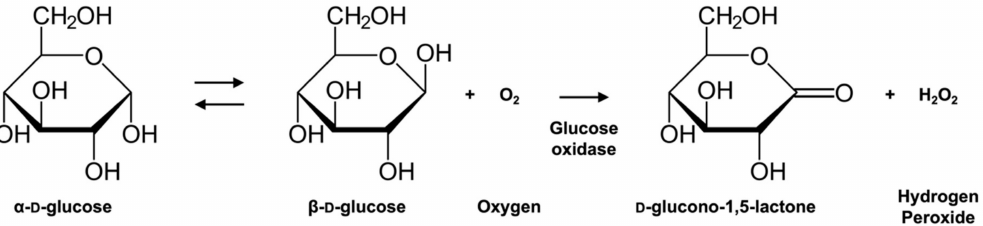
Scheme 1. Reaction scheme of glucose oxidation catalyzed by glucose